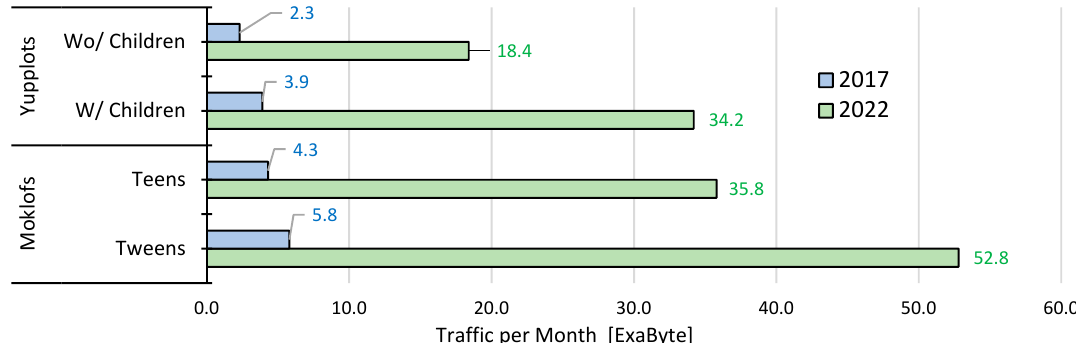
Figure 12. Traffic per month: impact of new clusters in traffic generation by 2022 versus 2017 in terms of mobile video traffic.